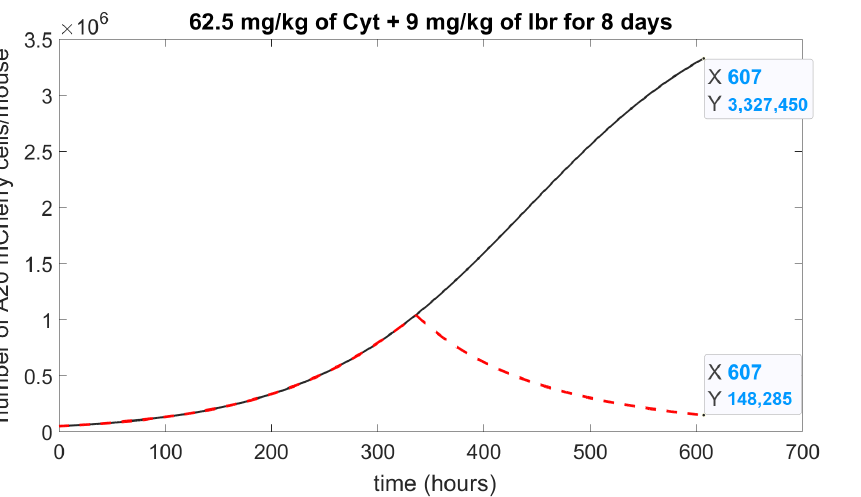
Figure 6. Numerical simulation of drug combination. The simulation of the model (1)–(3) represents the number of A20 mCherry cells affected by the effect of Ibr with Cyt. A solid black curve is a control, without a drug; a dashed red curve is 62.5 mg/kg of Cyt and 9 mg/kg of Ibr; Initial concentration of A20 mCherry cells, A ( 0 ) = 5 × 10 4